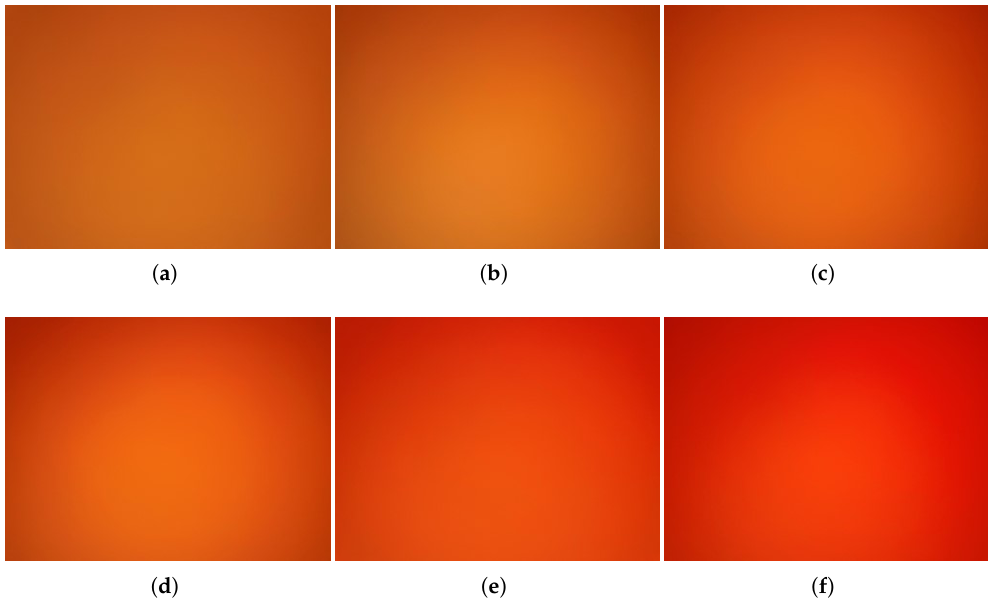
Figure 8. Actual photos of human blood ( a ) 6 g/dL; ( b ) 7 g/dL; ( c ) 8 g/dL; ( d ) 9 g/dL; ( e ) 10 g/dL;